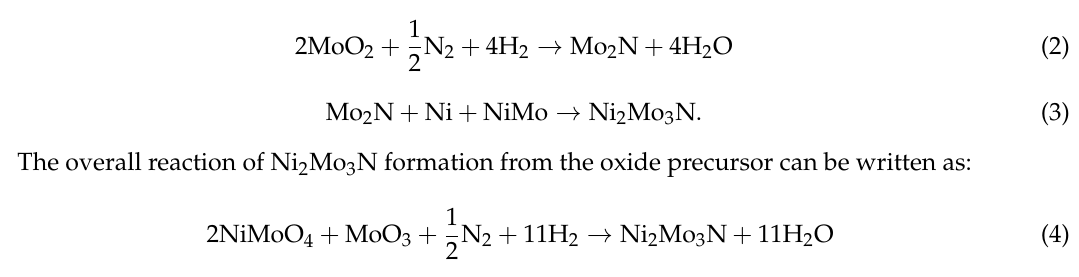
Table 1. Comparison of weight changes calculated from Equations (1)–(3) with the experimental values obtained from thermogravimetric analysis.